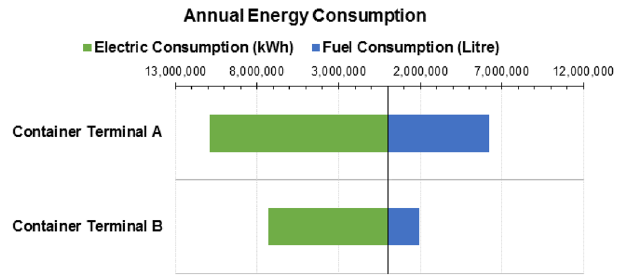
Figure 3. Annual energy use of container terminals.